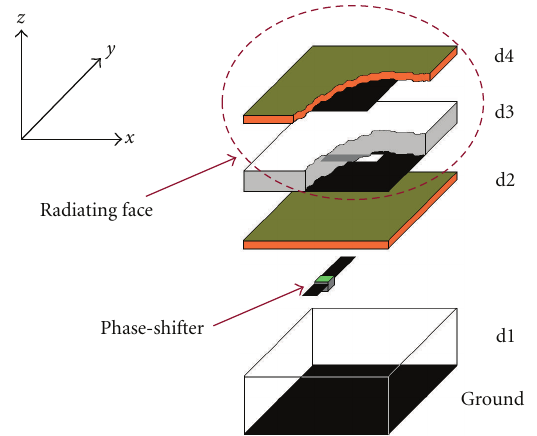
Figure 1: Expanded view of a single reconfigurable periodic ele- ment based on patches aperture-coupled to delay